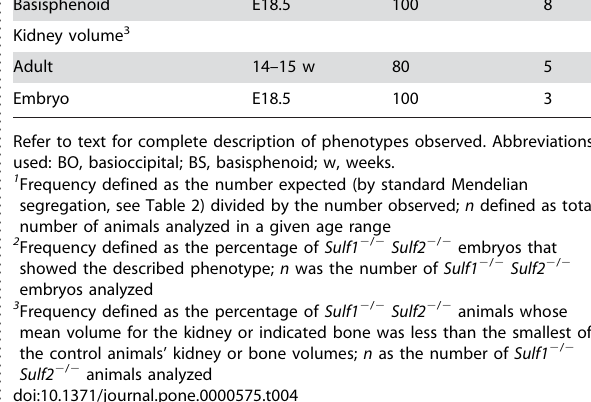
Refer to text for complete description of phenotypes observed. Abbreviations used: BO, basioccipital; BS, basisphenoid; w, weeks. 1 Frequency defined as the number expected (by standard Mendelian segregation, see Table 2) divided by the number observed; n defined as total number of animals analyzed in a given age range 2 Frequency defined as the percentage of Sulf1 2 / 2 Sulf2 2 / 2 embryos that showed the described phenotype; n was the number of Sulf1 2 / 2 Sulf2 2 / 2 embryos analyzed 3 Frequency defined as the percentage of Sulf1 2 / 2 Sulf2 2 / 2 animals whose mean volume for the kidney or indicated bone was less than the smallest of the control animals’ kidney or bone volumes; n as the number of Sulf1 2 / 2 Sulf2 2 / 2 animals